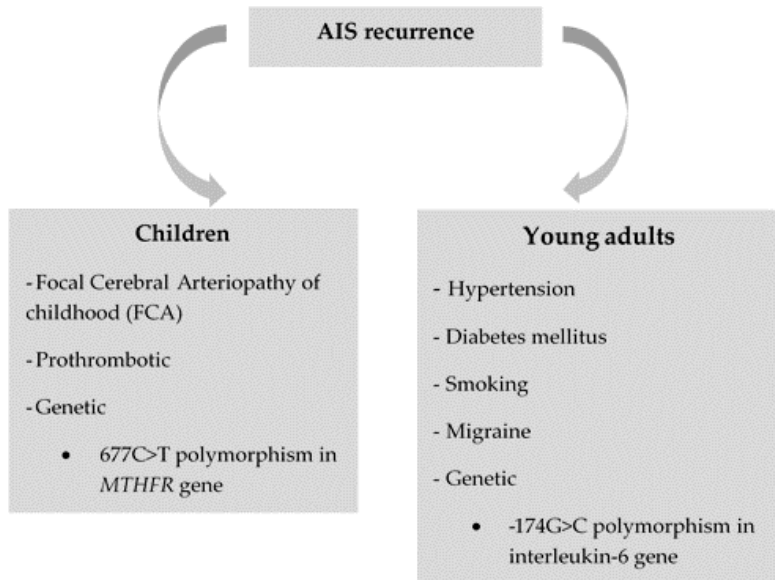
Figure 1. Potential risk factors for stroke recurrence identified in di ff erent pediatric and young adult populations.